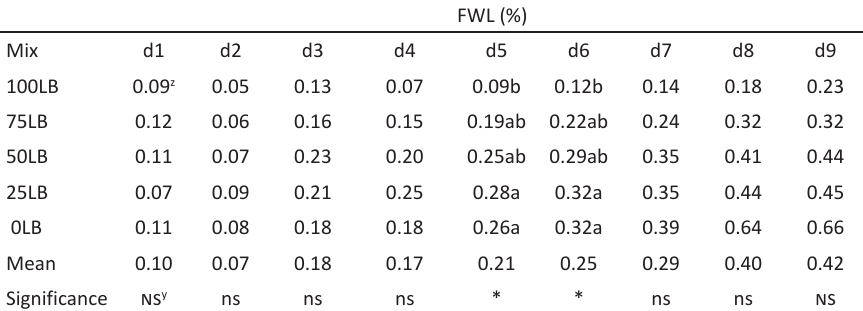
Table 1. Fresh weight loss (FWL) in fresh-cut product (100% ‘Lollo Bionda’ lettuce [ 100LB ] , 75% LB [ 75LB ] , 50% LB [ 50LB ] , 25% LB [ 25LB ] , 0% LB [ 0LB ] ) during the 9-d shelf life